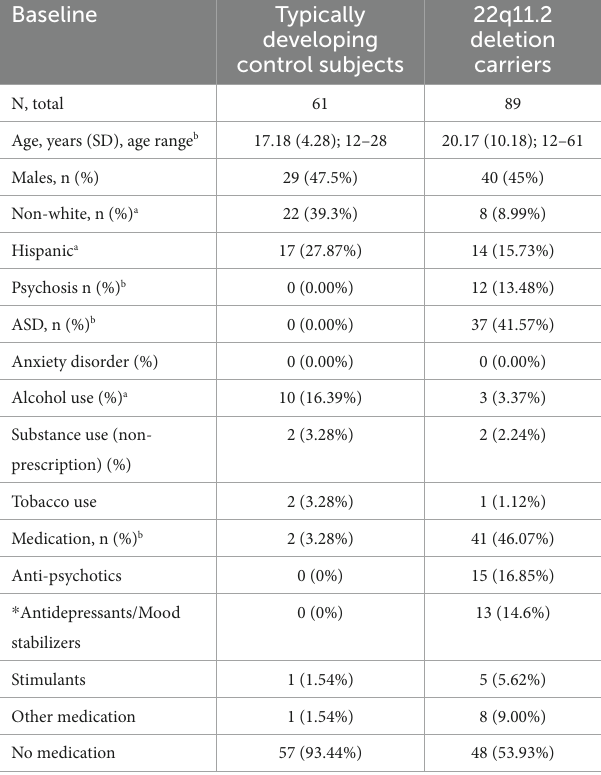
TABLE 1 Baseline characteristics: 22qDel carriers and TD controls. TABLE 2 Baseline characteristics: NAPLS 2 and 3 (CHR-P subjects and TD